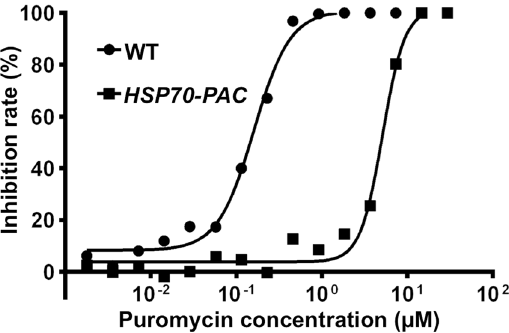
Figure 1. Puromycin resistance assay of wild type and pac -transfected parasites. Growth inhibition of wild type (WT) and pXL/hdhfr-pac-egfp (Fig. 2a)-transfected parasites ( HSP70-PAC ) was assessed by determining schizont development at a range of puromycin